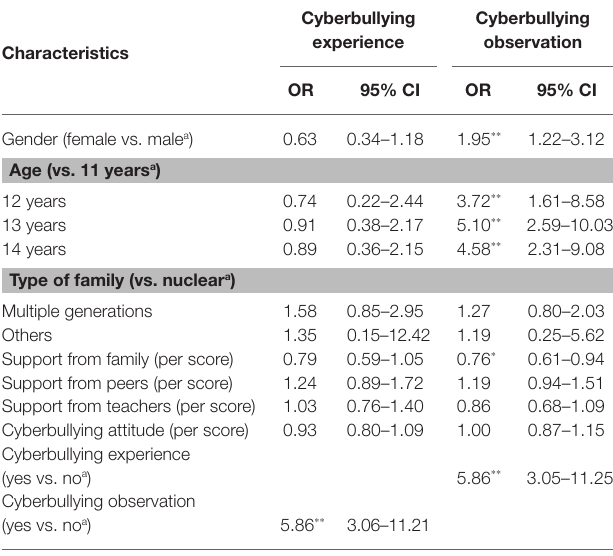
TABLE 4 | Associated factors with cyberbullying experience and